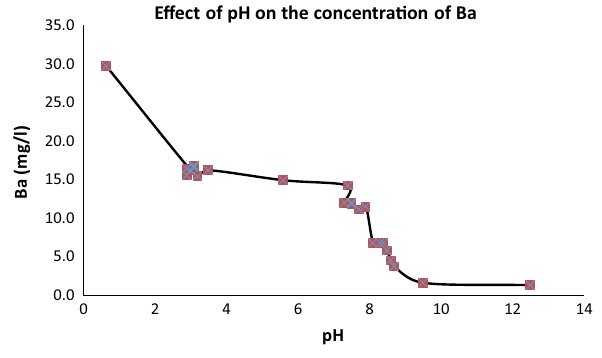
Fig. 2 Effect of pH on the concentration of